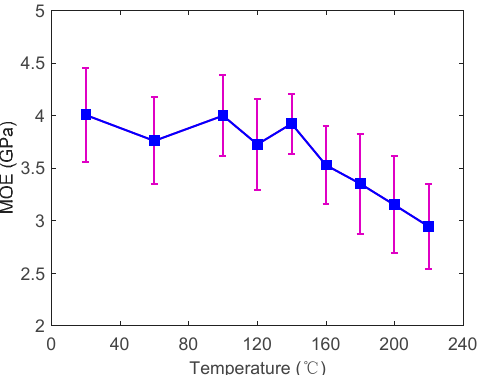
Figure 11. The modulus of elasticity with standard deviations (purple line) at elevated temperatures.